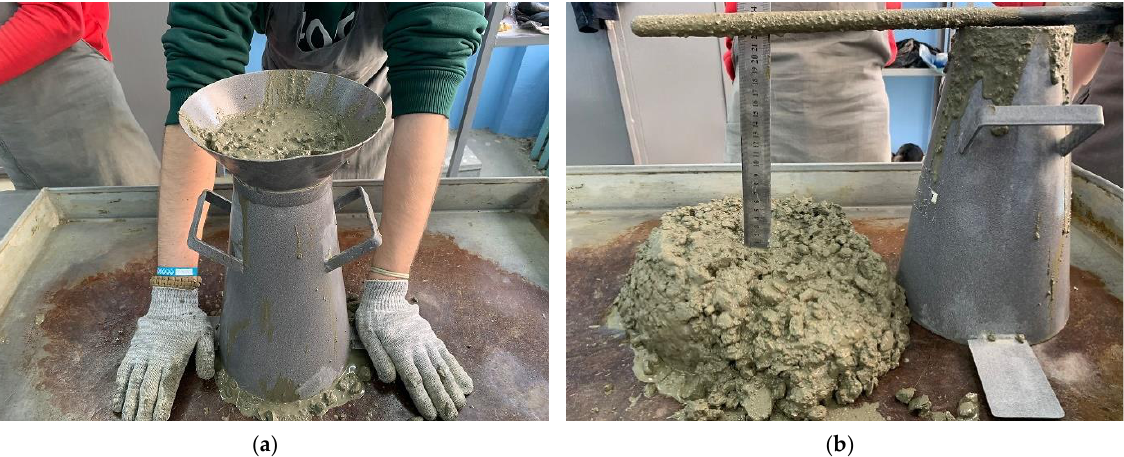
Figure 4. Testing the concrete mix for workability: ( a ) filling and bayoneting the mix in a cone; ( b ) slump measurement.